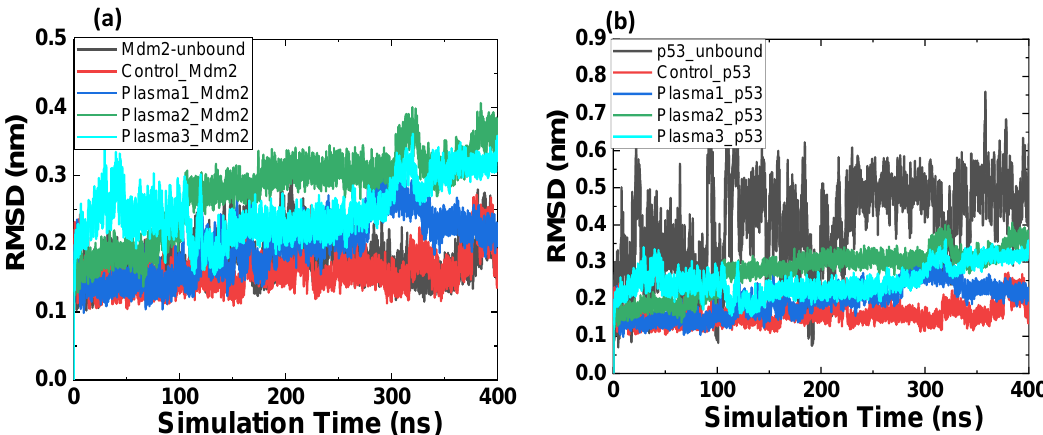
Figure 5. Root mean square deviation (RMSD) of the Cα atoms ( a ) Mdm2 and ( b ) p53 in Mdm2 unbounded (black), Mdm2–p53 complex, plasma1, plasma2, and plasma3.